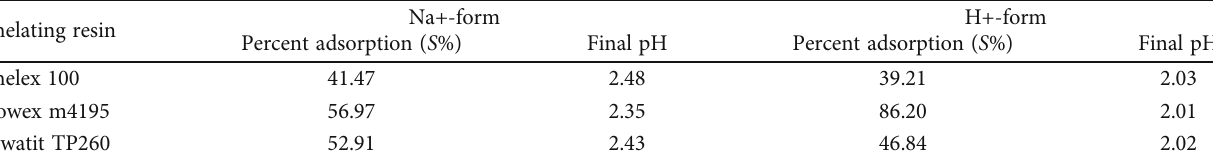
Table 3: Percentage copper (II) ions adsorbed onto Na+-form and H+-form chelating resins and changed pH of the acidic solutions. Chelating